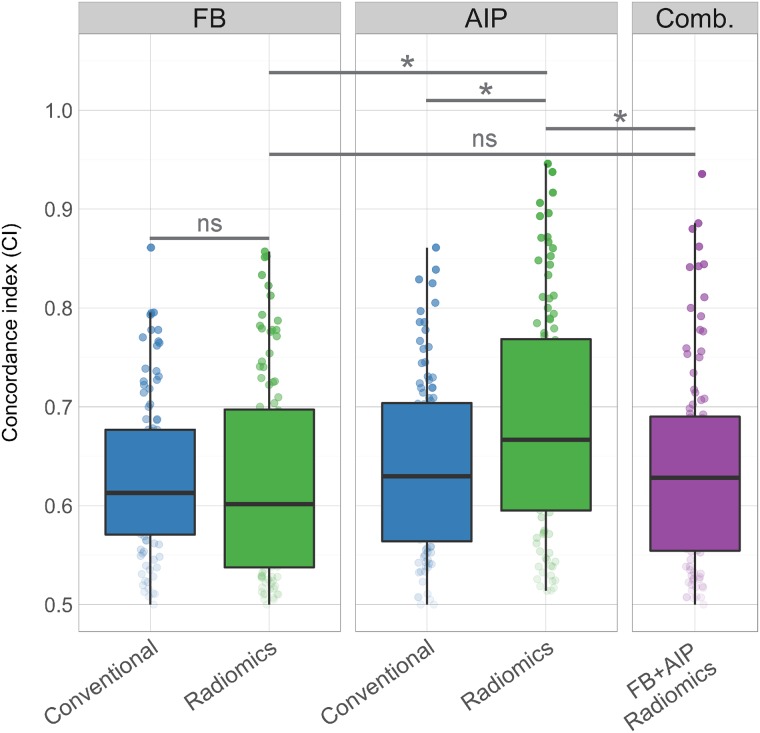
Performance of each multivariate model in predicting distant metastasis.Concordance indices are reported for the FB and AIP conventional and radiomic models, and a combined FB+AIP radiomics model, comparing the performance of each of model and image type. Cross validation was performed (80% training, 20% validation) to generate 100 models for each model type. Comb. Indicates the combined FB and AIP radiomics model. *p-value < 0.05; “ns” indicates not significant (p-value > 0.05).